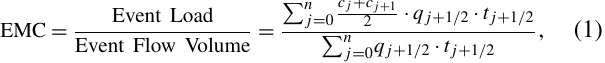
Mostly dry tropics and rela- tively dry areas, with clear sea- sonal variability in rainfall